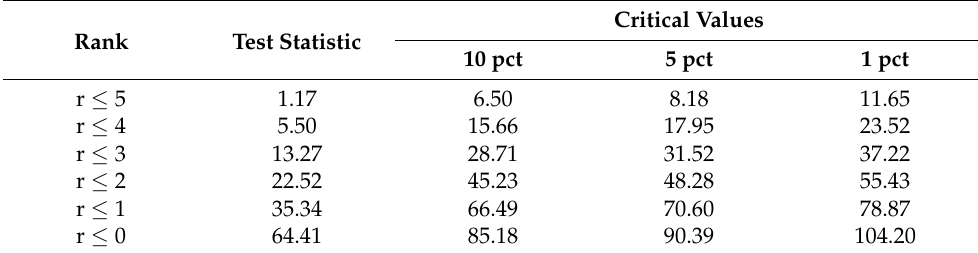
Table 3. Johansen Cointegration—Trace Statistic with linear trend. Rank Test